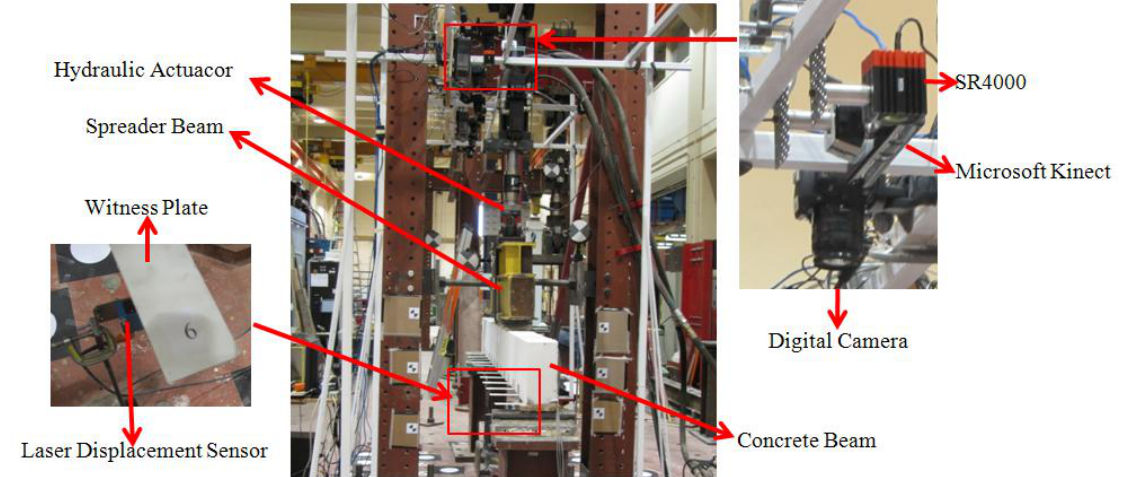
Figure 3. Photographic image of the experiment